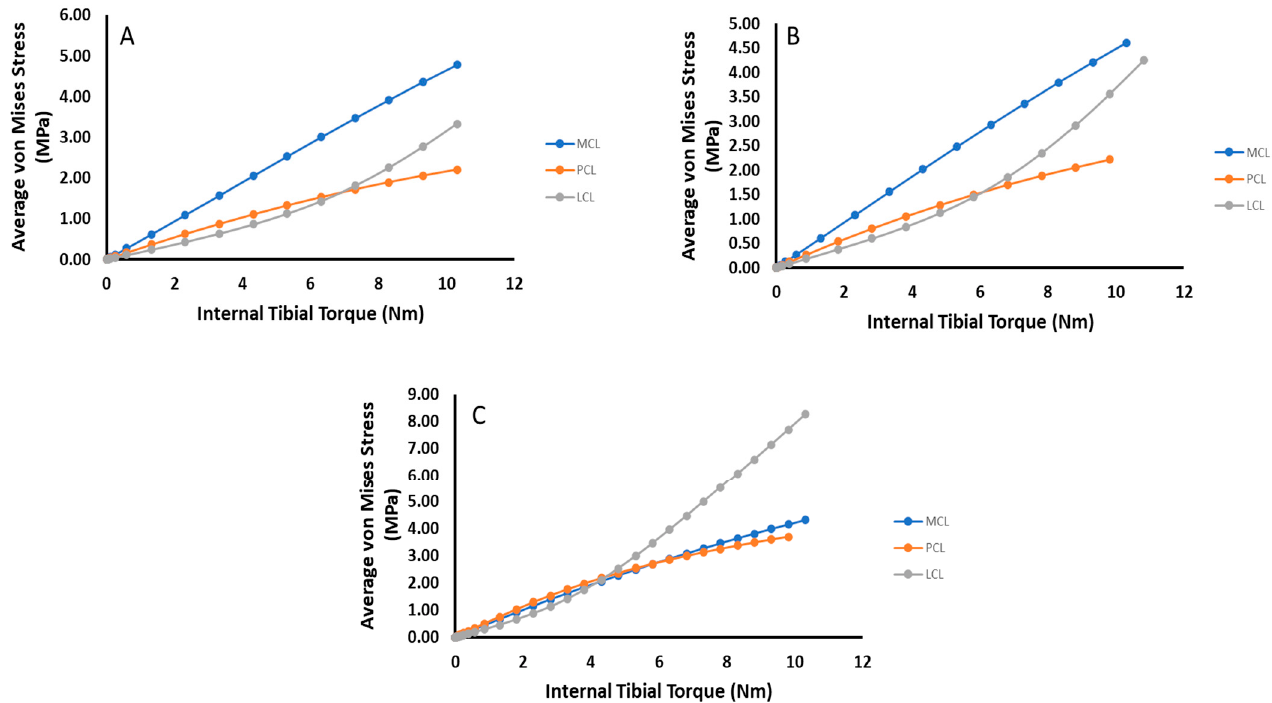
Figure 13. Comparative plots of the relative stress amounts for each ligament for each damage state under tibial torque loading. ( A ) no damage ( B ) 2000 N Damage ( C ) ACL Removed.